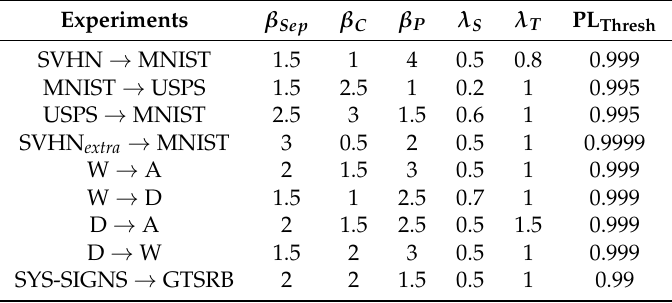
Table 5. The best set of hyper-parameters for TripNet for the experiments reported in Table 5. The parameters β Sep , β P , and β C are the balancing parameters for the triplet loss from Equation (9); λ T and λ S are the balancing parameters between the source and target classification losses from Equation (4); and PL Thresh is the minimum confidence level provided by the classifier so that the image would be considered for